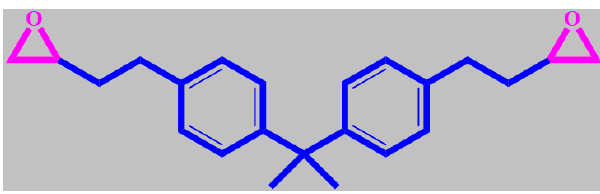
Figure 3. Chemical structure of diglycidyl ether bisphenol-A (DGEBA) epoxy resin.